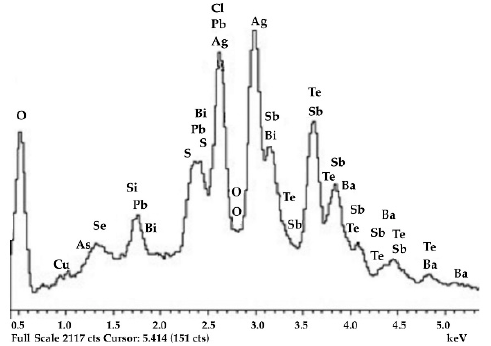
Figure 7. General EDX spectrum of residues from leaching ClO - /OH -. Table 7. Semi-quantitative analysis of residues from leaching ClO - /OH